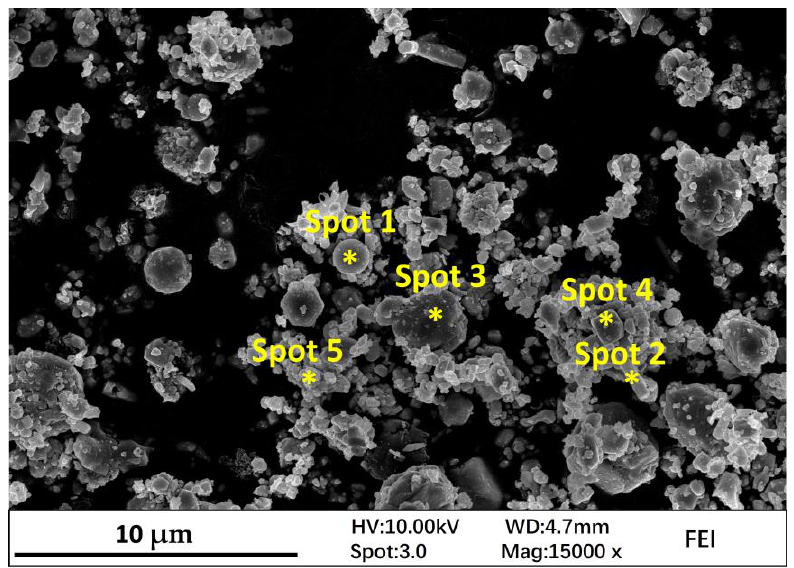
Figure 11. SEM image and EDS analysis areas of atmospheric leaching residue (initial acidity = 160 g·L − 1 , leaching temperature = 90 °C, leaching time = 60 min, and L/S mass ratio = 5:1).